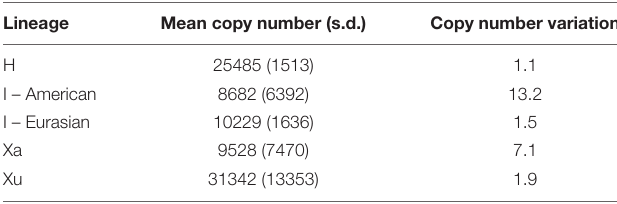
TABLE 3 | Copy number variation of native Hordeum ribotype within the major phylogenetic